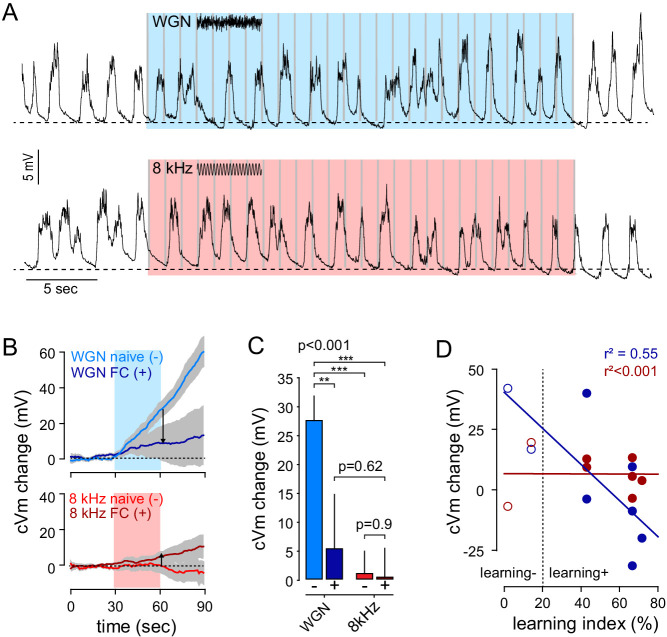
Fear conditioning (protocol 1) occludes WGN-evoked somatic plateau potentials.(A) Example traces of postsynaptic membrane potential recorded from an individual FrA pyramidal neuron upon WGN (CS-, top) and 8 kHz (CS+, bottom) auditory stimulation after fear conditioning. The effect of both stimuli was tested on the same cell. (B) Averaged cVm change (±sem) evoked by WGN (top) and 8 kHz tones (bottom) before (naive (-)) and after fear conditioning (FC (+)). (C) Effect of WGN and pure 8 kHz tone on cVm change before (-, n = 22) and after learning (+; n = 8). As compared to naive mice, WGN failed to activate FrA pyramidal neurons in conditioned mice (WGN+: 5.4 ± 9 mV, n = 8; WGN-: 27.6 ± 4 mV, n = 22; p=0.008). Thus, the difference between WGN and 8 kHz-induced cVm change observed in naive mice (14 naive mice; WGN-: 27.6 ± 4 mV; 8kHz-: 1.1 ± 4 mV; n = 22; p<0.001; paired t-test) disappeared after fear conditioning (five conditioned mice; WGN+: 5.4 ± 9 mV; 8 kHz+: 0.5 ± 5 mV; n = 8; p=0.698; paired t-test). p<0.001, one-way anova; ***, p<0.001; **, p<0.01, Holm-Sidak comparisons. (D) Relation between the learning index and WGN (blue)- and 8 kHz (red)-induced cVm change after conditioning. As opposed to 8kHz-cVm change that was not different between behavioral performance (r²<0.001), WGN induced stronger cVm change in low freezing mice indicating that WGN- somatic plateaus are negatively correlated with behavioral performance (WGN: r²=0.55; 8 kHz: r²<0.001). Open/filled circles, individual cells from non-learning/learning mice, respectively.Figure 3—figure supplement 3—source data 1.Sound-evoked depolarization after fear learning.